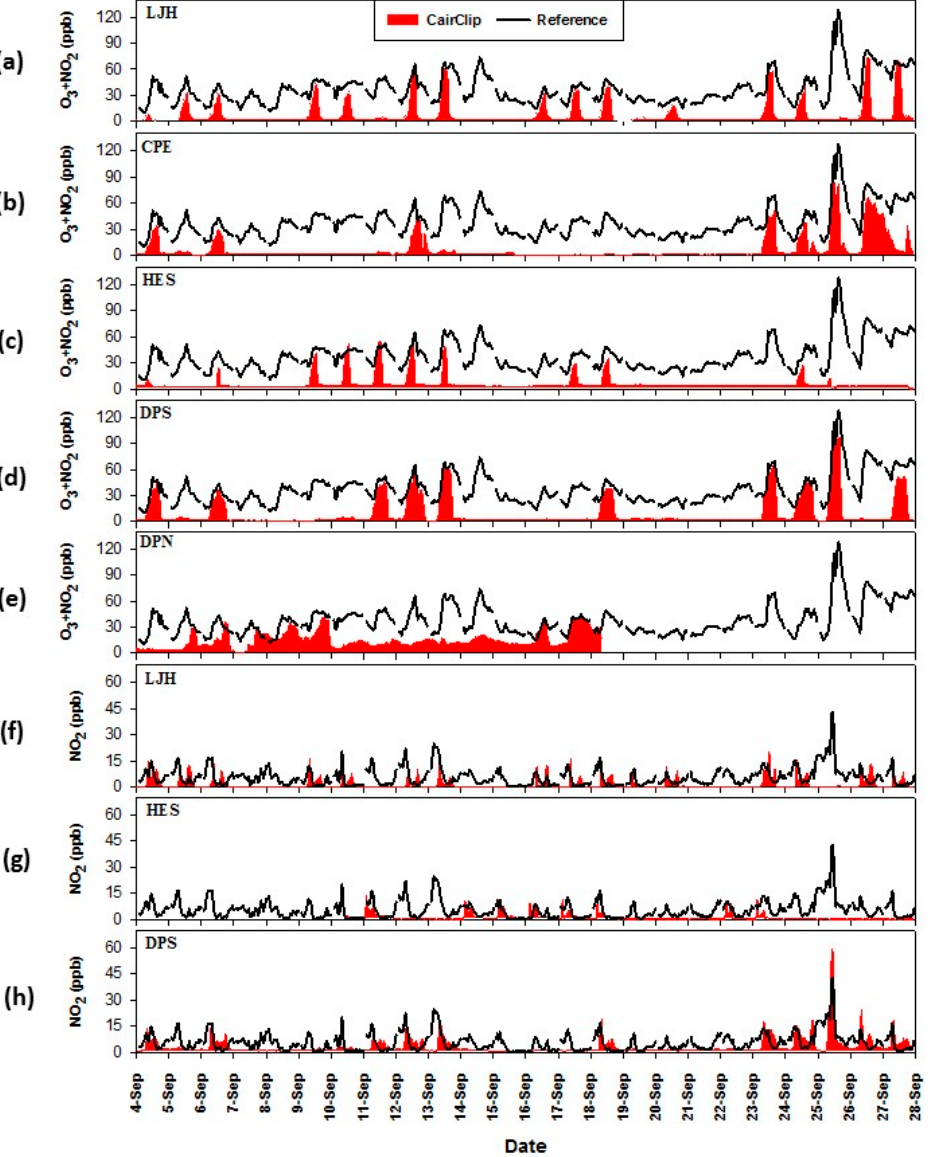
Figure 6. Measurements collected at the citizen science-operated sites in the Houston campaign for the ( a ) to ( e ) the CairClip O 3 /NO 2 sensor and ( f ) to ( h ) the CairClip NO 2 sensor.